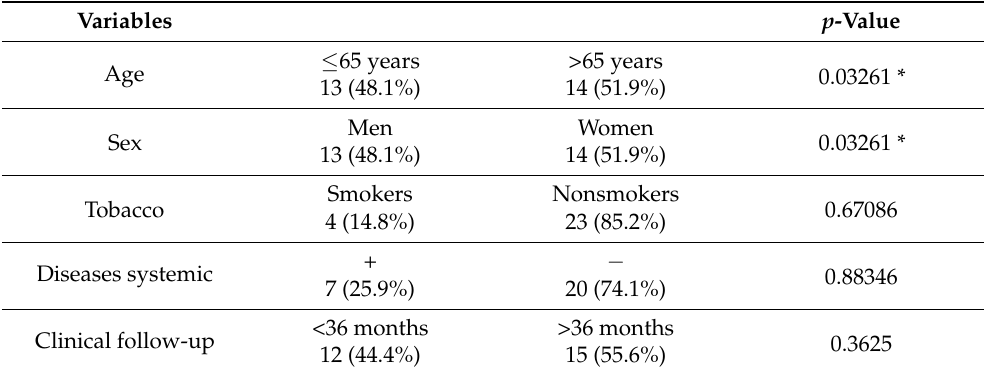
Table 1. Demographic and clinical variables ( n = 26).